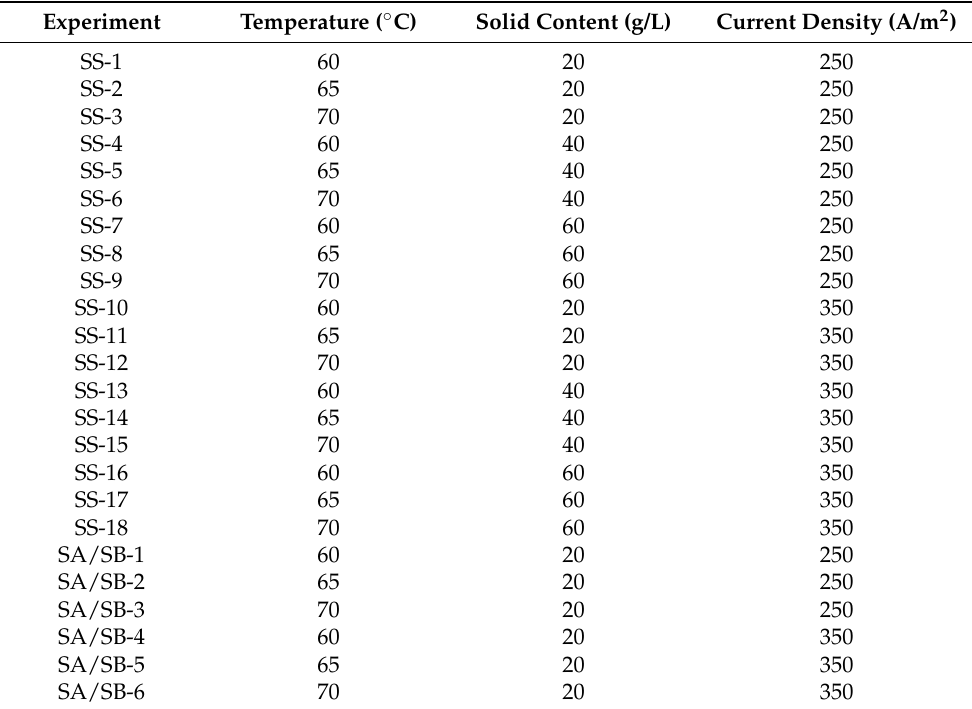
Table 2. Experimental series used for the particle entrapment experiments. SS stands for synthetic slime. SA and SB refer to industrial anode slimes A and